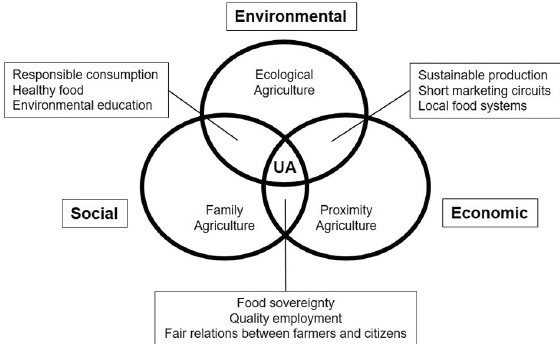
Fig.1. The significance of agriculture in the context of sustainable development of the city. Source: own compilation.